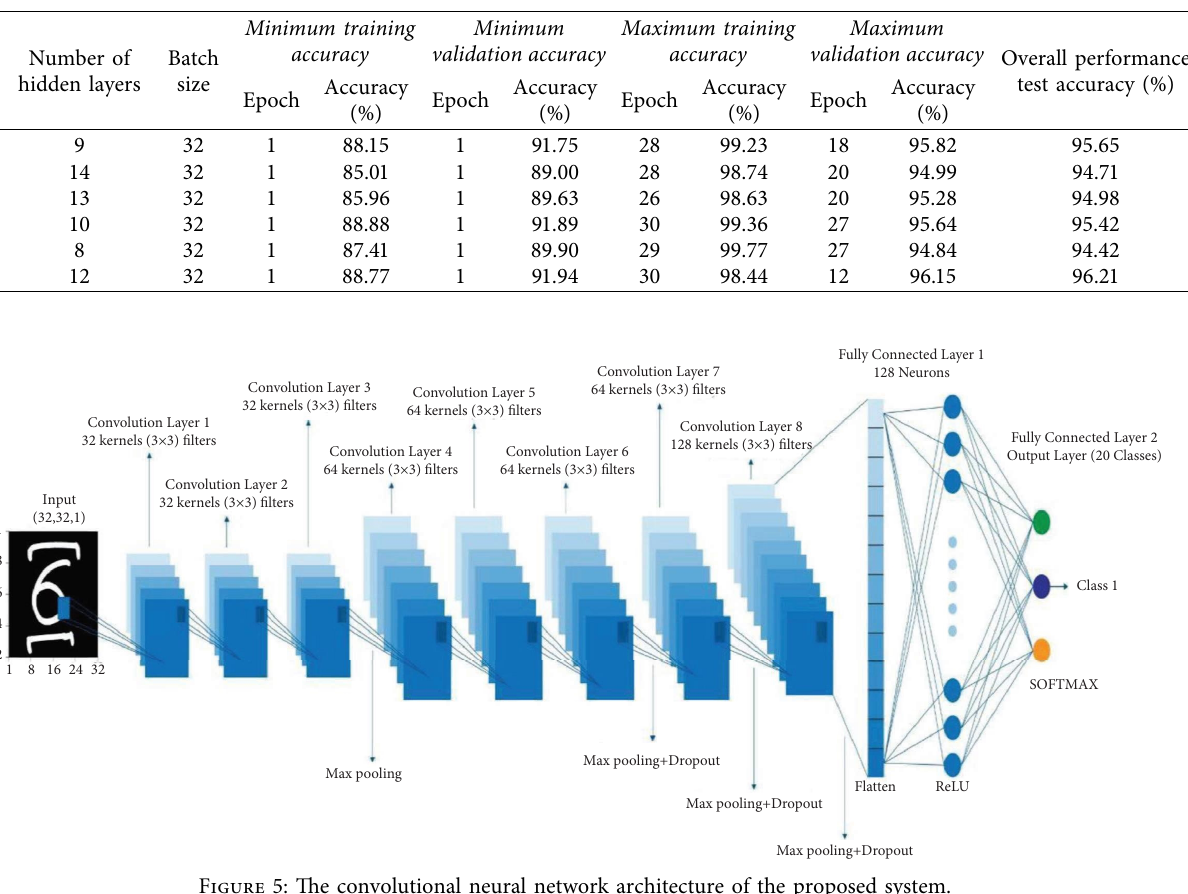
Table 1: Performance of the CNN for the six diferent cases for various hidden